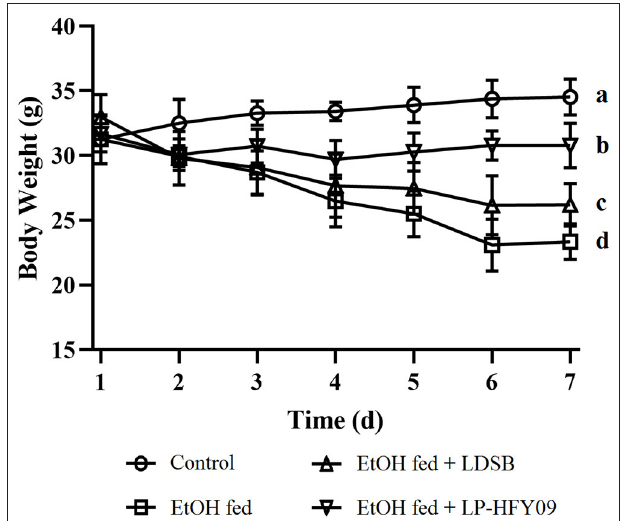
FIGURE 1 | Changes of body weight during the experiment. a − d Means significant differences ( p < 0.05). Control, mice without treatment; EtOH fed, mice treated with 56 ◦ ethanol of 0.13 ml/10g bw; EtOH fed + LDSB, mice treated with 1.0 × 10 9 CFU/kg of Lactobacillus delbruechill subsp. bulgaricus before ethanol-treatment; EtOH fed + LP-HFY09, mice treated with 1.0 × 10 9 CFU/kg of Lactobacillus plantarum HFY09 before